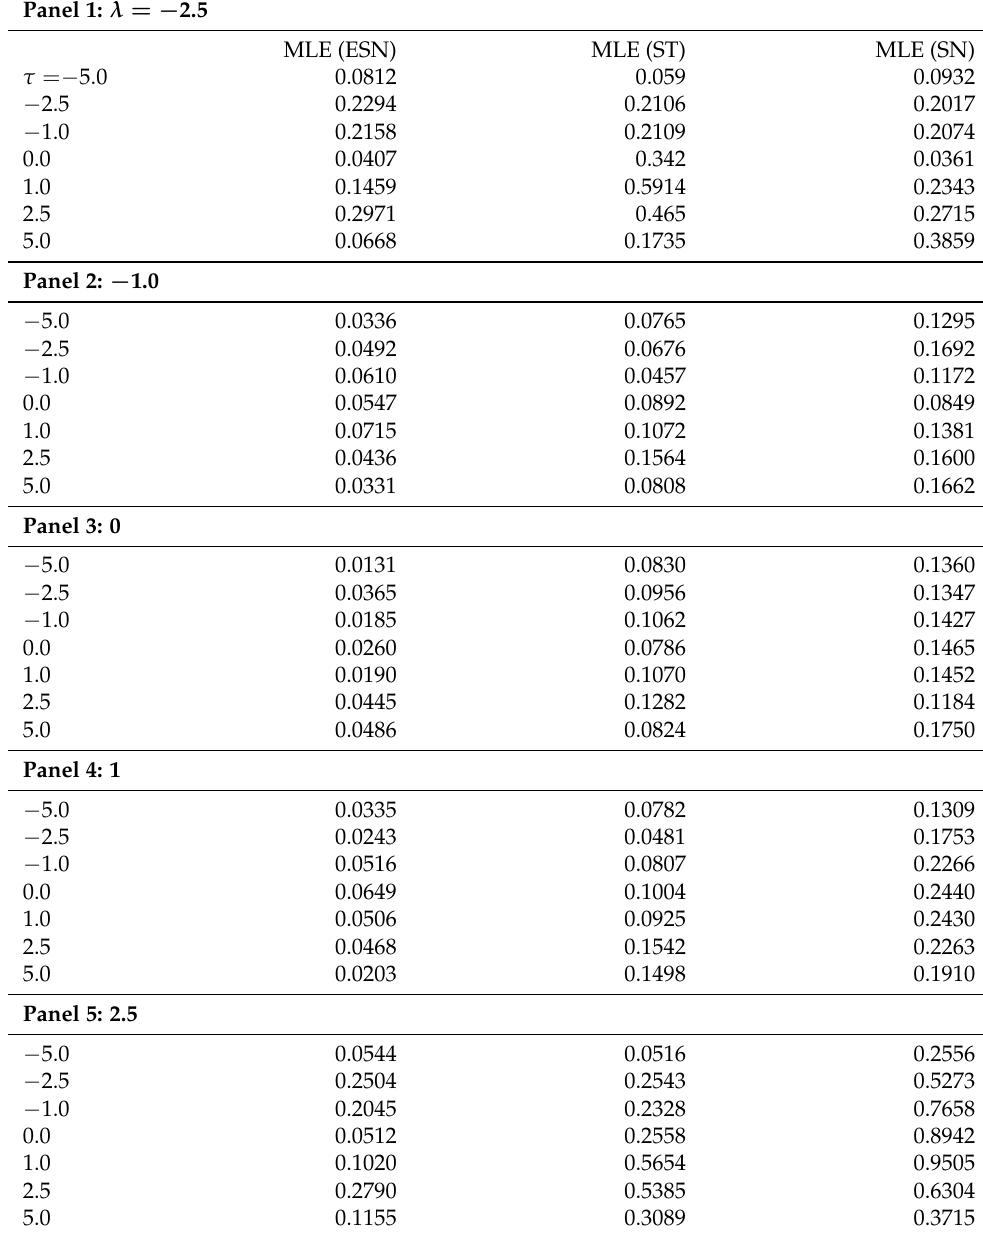
Table 16. Root mean square errors in the critical